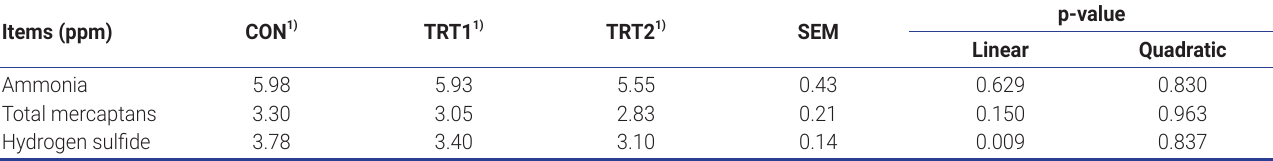
Table 5. Effect of dietary supplementation Achyranthes japonica extracts on fecal gas emission in growing pigs Items